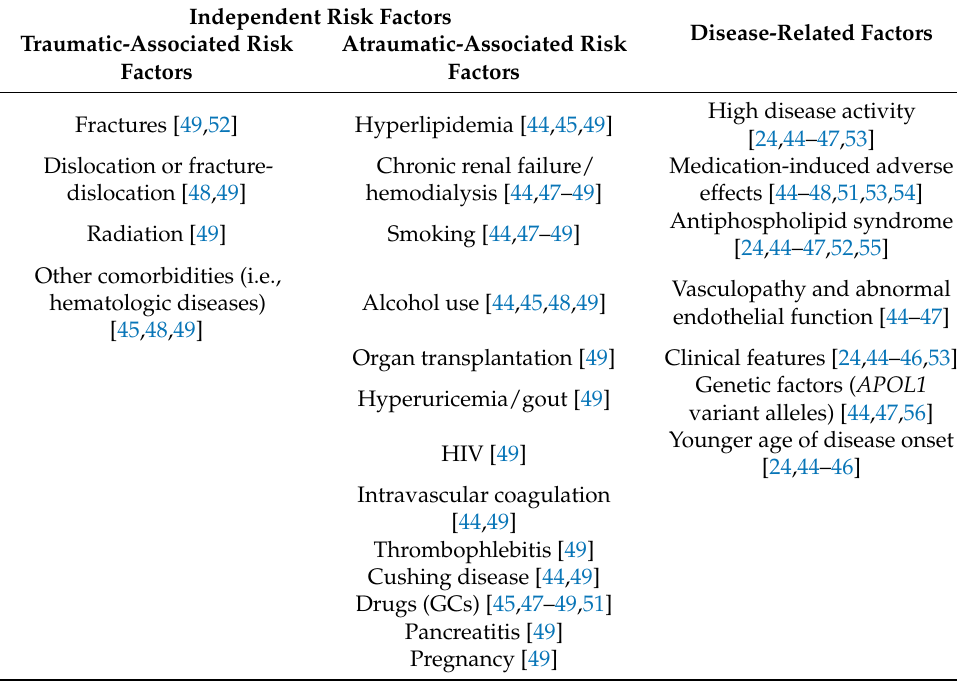
Table 3. Avascular necrosis risk factors in